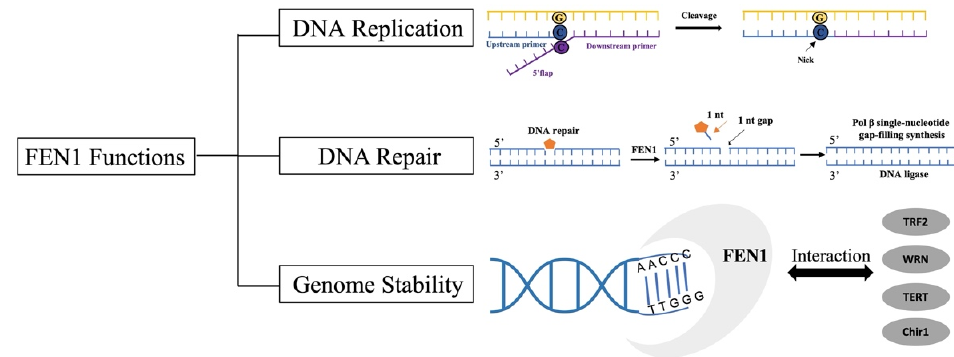
Figure 2. Major functions of